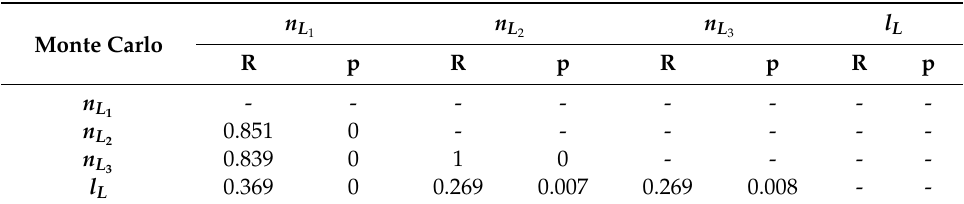
Table 6. Covariance (correlation and probability) values for Monte Carlo analysis (3D: 20 µ m; image: 0.1 pixel).